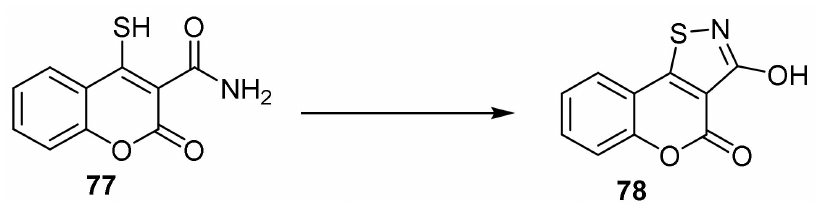
Up to our knowledge, only one article discussed the synthesis of 4 H -chromeno[3,4- d ]isothiazol-4-one [53]. The reported method included cyclization of 4-mercapto-2-oxo-2 H - chromene-3-carboxamide ( 77 ) on heating with bromine in ethyl acetate to form 2-hydroxy-